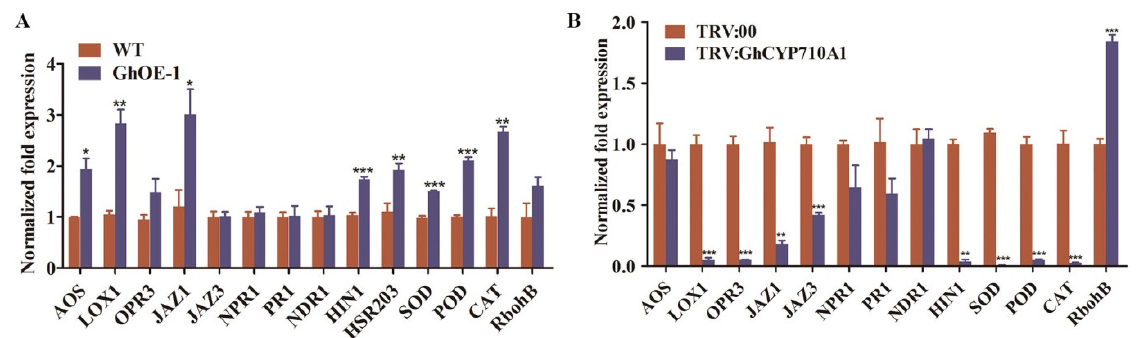
Figure 9. The expression changes of genes involved in disease resistance after Verticillium dahliae infection. ( A ) The expression levels of JA-/SA-mediated genes, HR-associated genes and ROS-related genes in root tissue of wild-type cotton and transgenic cotton by qRT-PCR after Verticillium dahliae infection for 12 h. WT: wild-type cotton; GhOE-1: GhCYP710A1 -overexpression transgenic cotton. ( B ) The expression levels of JA-/SA-mediated genes, HR-associated genes and ROS-related genes in TRV:00 and TRV: GhCYP710A1 cotton leaves by qRT-PCR after Verticillium dahliae infection for 7 days. Error bars represent the standard deviation of three independent replicates. * represents p < 0.05, ** represents p < 0.01, *** represents p < 0.001.